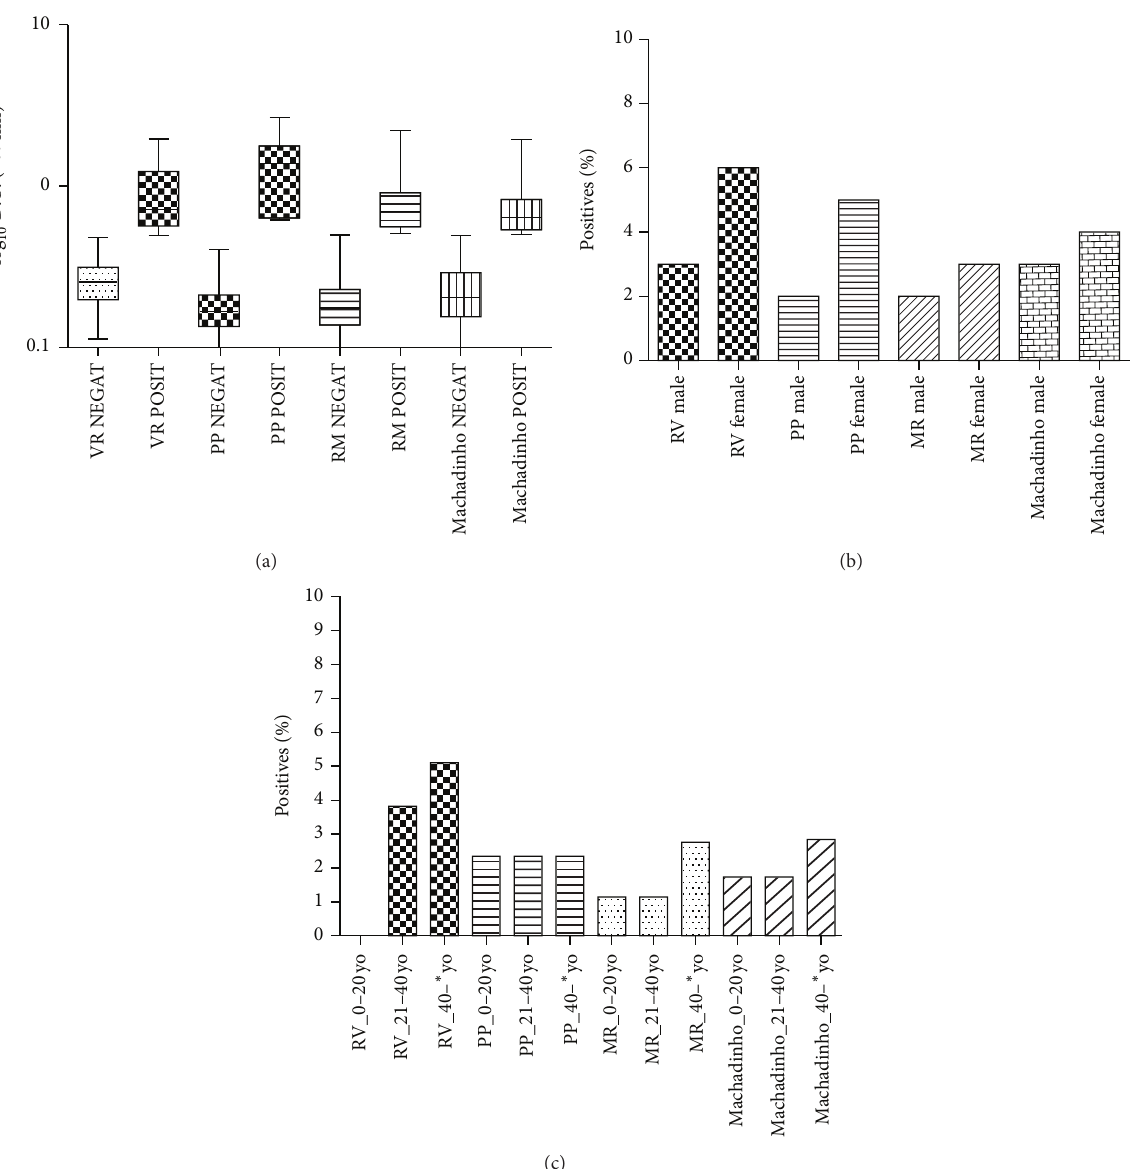
Figure 2: (a) demonstrated the absorbance values by ELISA for the total positive (POSIT) and negative (NEGAT) individuals from four different sites (Jacupiranga, SP, in Ribeira Valley, VR; Teodoro Sampaio/SP in Pontal Parapanema, PP; Machado River/RO, RM; and Machadinho do Oeste/RO) for the presence of anti-hantavirus IgG antibodies. (b) The graphic represent results from this four study sites in the tropical and subtropical region (Jacupiranga/SP in Ribeira Valley, VR; Teodoro Sampaio/SP in Pontal Parapanema, PP; Machado River/RO, RM; and Machadinho do Oeste/RO), categorized by gender. (c) The graphics represent results from this four study sites in the tropical and subtropical region (Jacupiranga/SP in Ribeira Valley, VR; Teodoro Sampaio/SP in Pontal Parapanema, PP; Machado River/RO, RM; and Machadinho do Oeste/RO) categorized by age (groups of 20 years). ∗ means “or